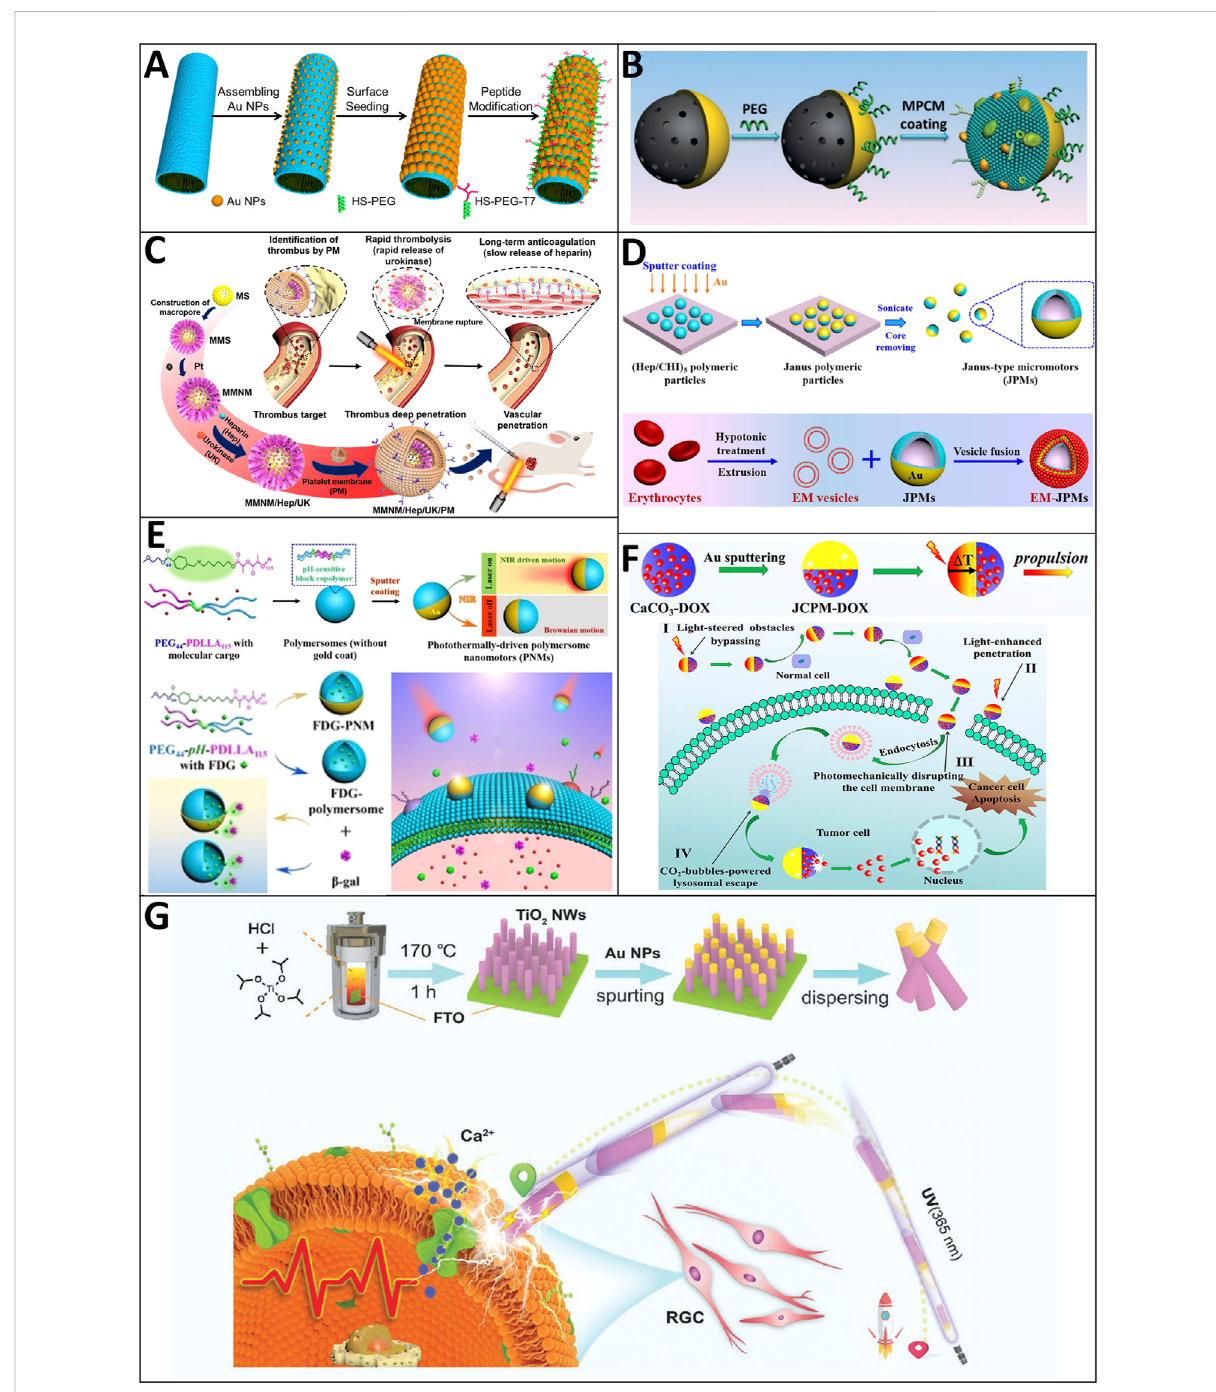
FIGURE 8 Motile drug delivery by light-driven MNRs. (A) Platinum nanoparticle (Pt NP)-modi fi ed polymer multilayer micromotors. (Wu et al., 2014) Copyright 2014. Reproduced with permission from American Chemical Society. (B) Macrophage cell membrane (MPCM)-camou fl aged Janus mesoporous silica nanomotor (JMSNM). (Xuan et al., 2018) Copyright 2018. Reproduced with permission from John Wiley and Sons. (C) Platelet- derivedporousnanomotors.(Wanetal.,2020)Copyright2020.TheAuthors,somerightsreserved;exclusivelicenseeAmericanAssociationfor the Advancement of Science. (D) Photothermally-driven polymersome nanomotors. (Shao et al., 2018) Copyright 2018. The Authors, some rights reserved; exclusive licensee American Chemical Society. (E) Membrane-cloaked Janus polymeric motors. (Shao et al., 2020) Copyright 2020.